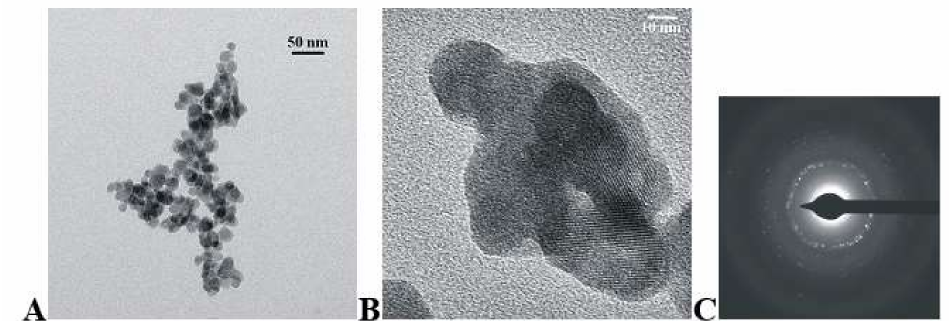
Figure 3. TEM ( A , B ) and SAED ( C ) images of KCaY(PO 4 ) 2 :5% Eu 3+ obtained by drying hydrother- mally obtained powders.